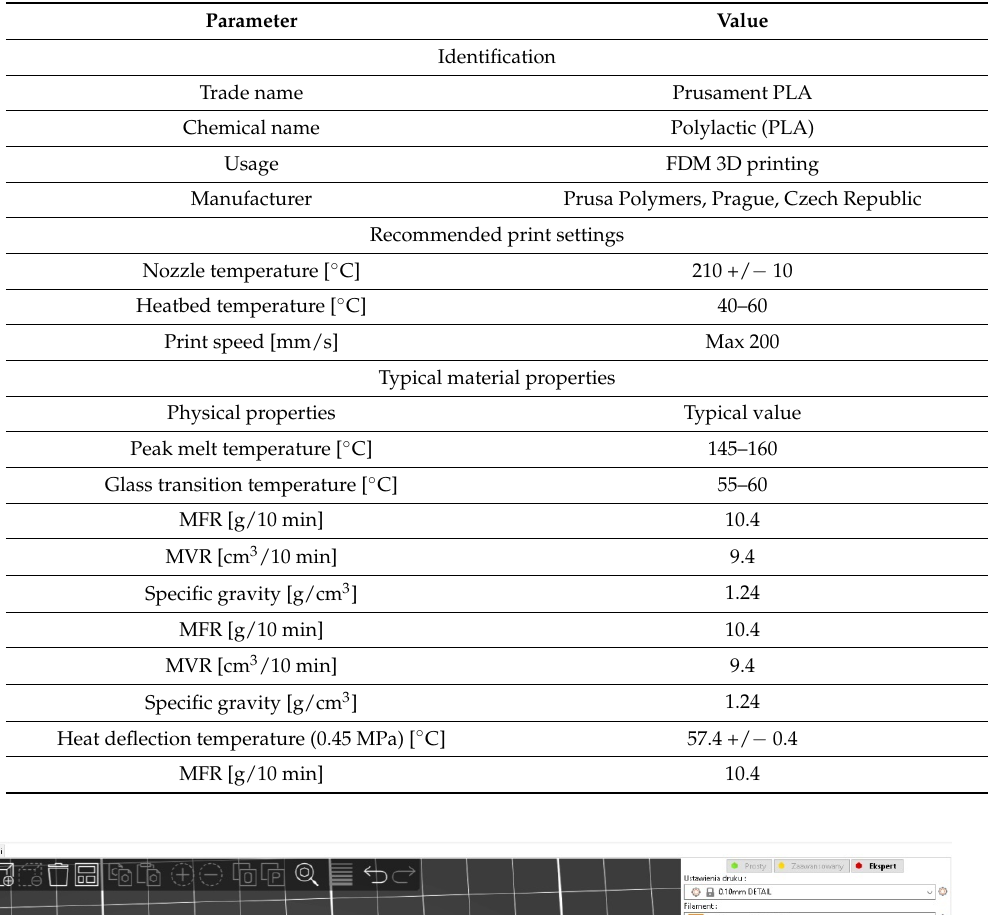
Table 3. Selected material parameters used.